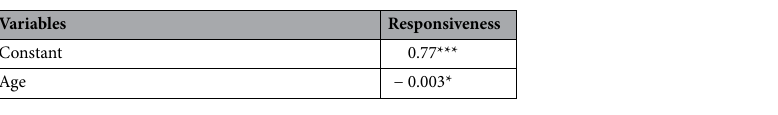
Table 11. OLS estimates with responsiveness as dependent variable and age and a constant as regressors. *p < 0.05, ***p < 0.001.